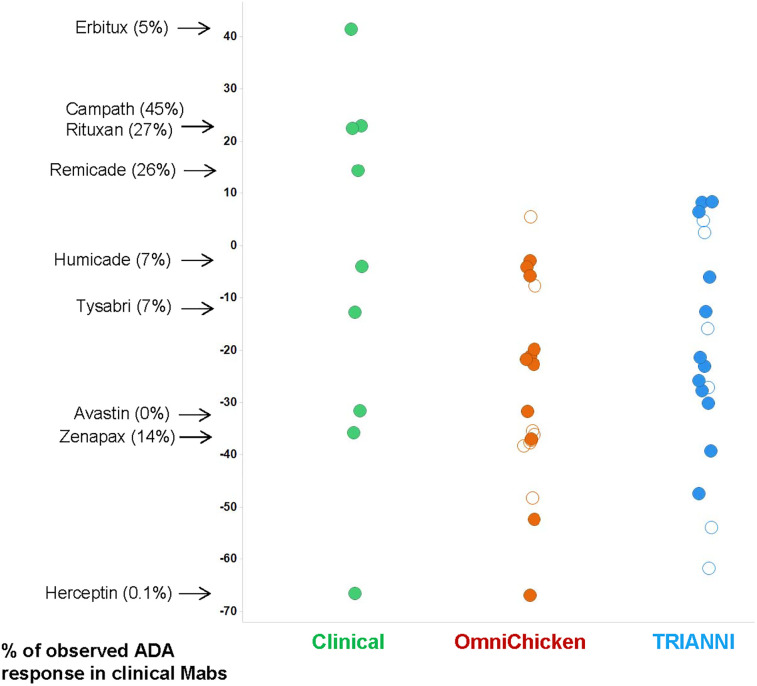
EPIVAX scores for the OmniChicken- (brown), TRIANNI-derived (blue) and a panel of antibodies that have been tested in humans (green).For this latter group the reported % of ADA observed in clinical trials is indicated. Empty circles represent the mAbs selected for the developability study.